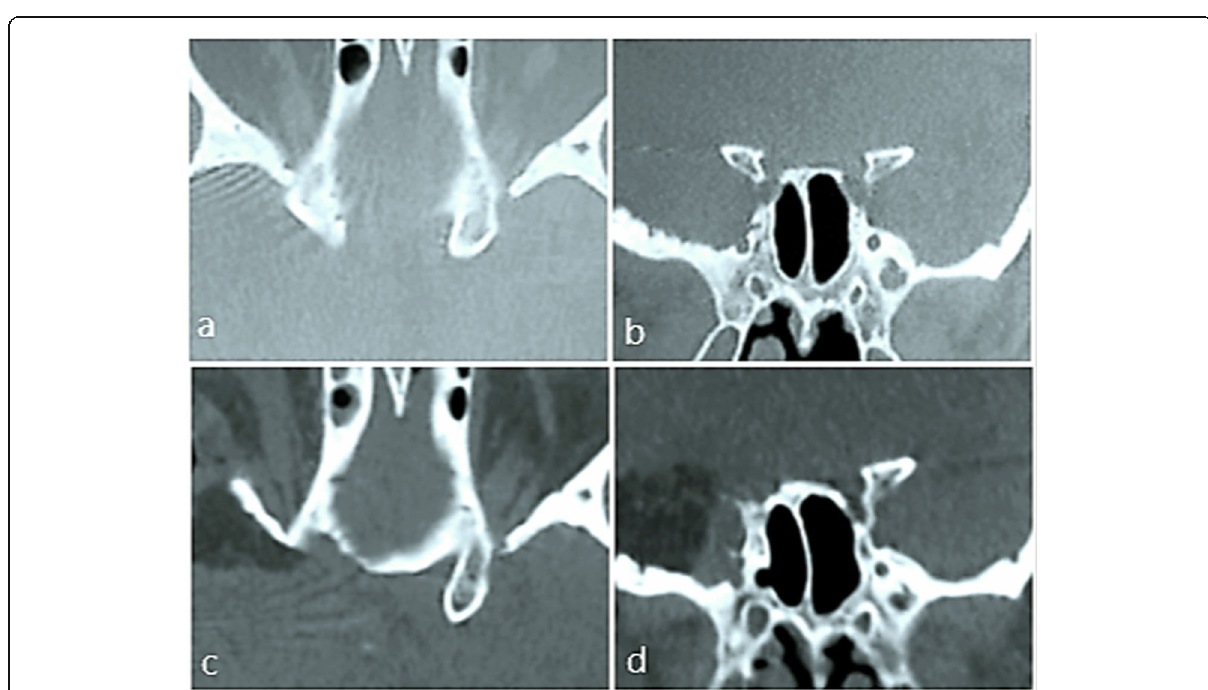
Fig. 2 a – d Preoperative and postoperative helical bone window CT scan after right extradural anterior clinoidectomy for ACM patient. a , b Preoperative axial and coronal view, respectively. c , d Postoperative axial and coronal view showing the extent of bone drilling involving the right ACP, the optic canal roof, and the optic